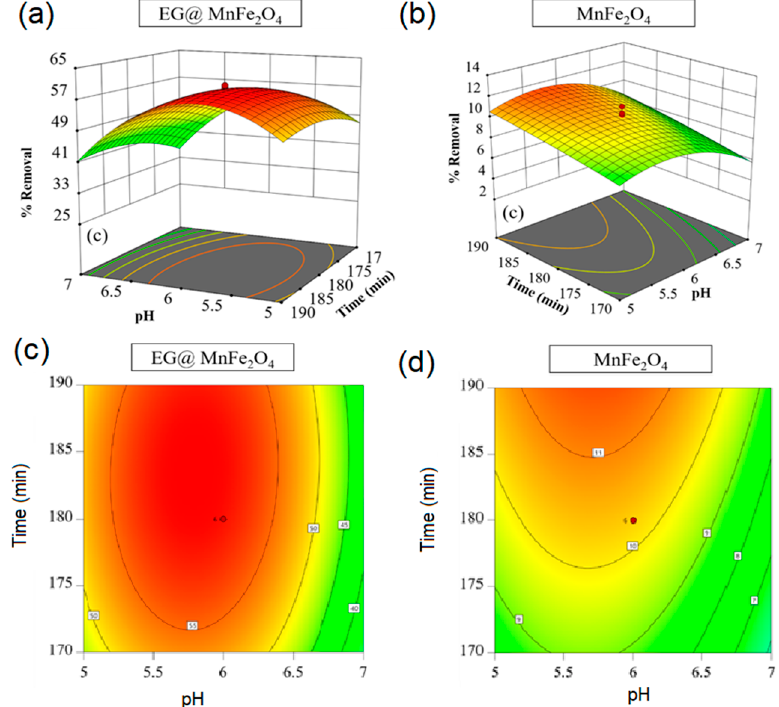
Figure 11. 3-D surface responses ( a , b ) and their respective contour plots ( c , d ): Effect of solution pH and contact time on the adsorption of CR onto EG@MnFe 2 O 4 (a,c) and MnFe 2 O 4 (b,d).